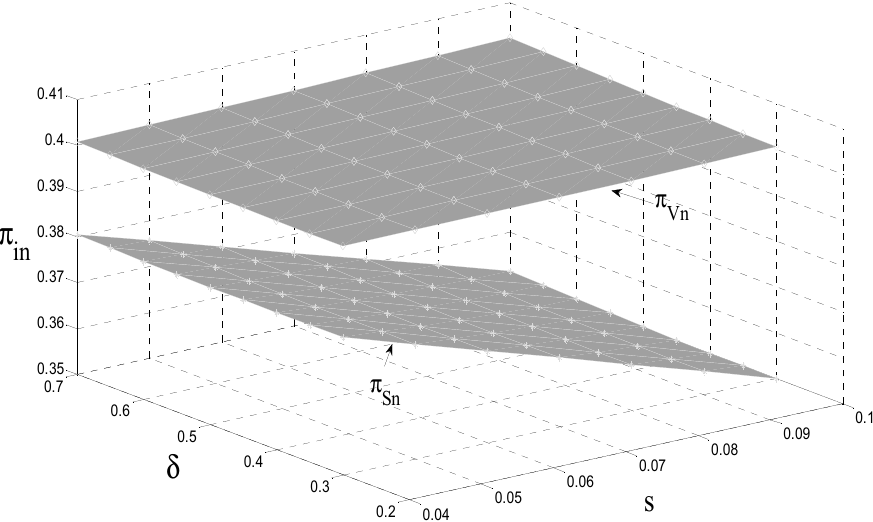
Figure 5. The impact of s and δ on the revenue of original manufacturers.